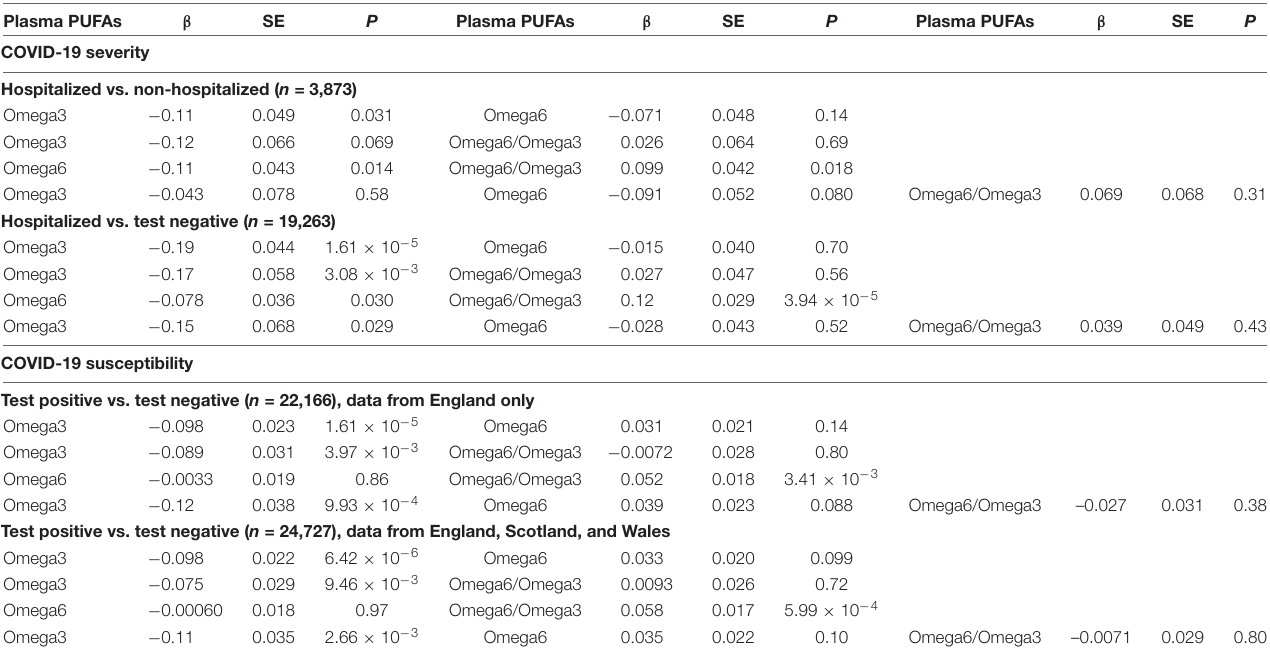
TABLE 3 | Associations of multiple polyunsaturated fatty acids (PUFAs) with COVID-19 susceptibility and severity.* Plasma